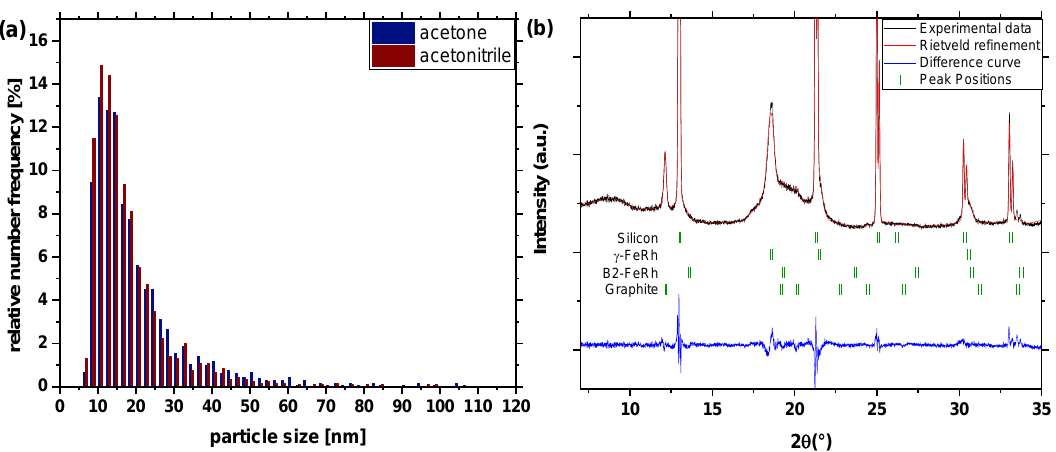
Figure 2. ( a ) Number-weighted particle size distribution (extracted from TEM images) of synthesized particles by laser ablation in acetone and acetonitrile and ( b ) XRD-pattern of Fe 50 Rh 50 nanoparticles obtained by laser ablation in acetone and acetonitrile. The known XRD peaks of γ— FeRh, graphite and B2-FeRh and silicon are indicated.